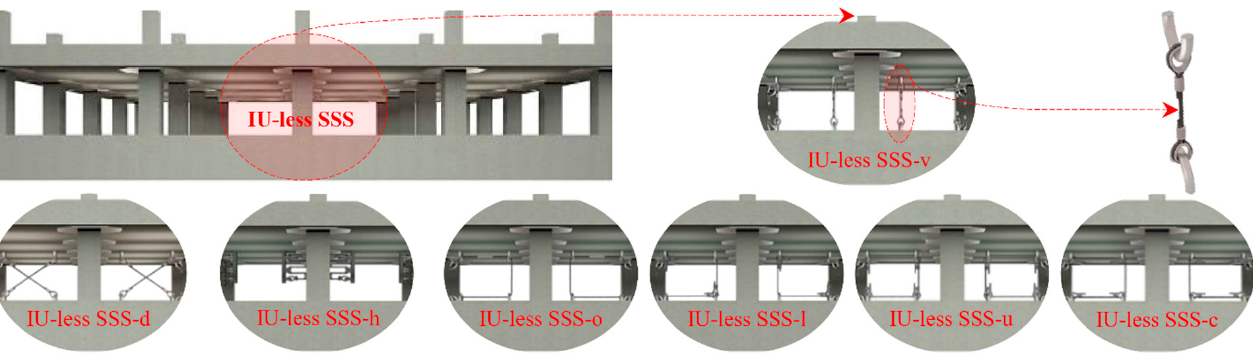
Figure 5. SSS in the IU-less traditional style of